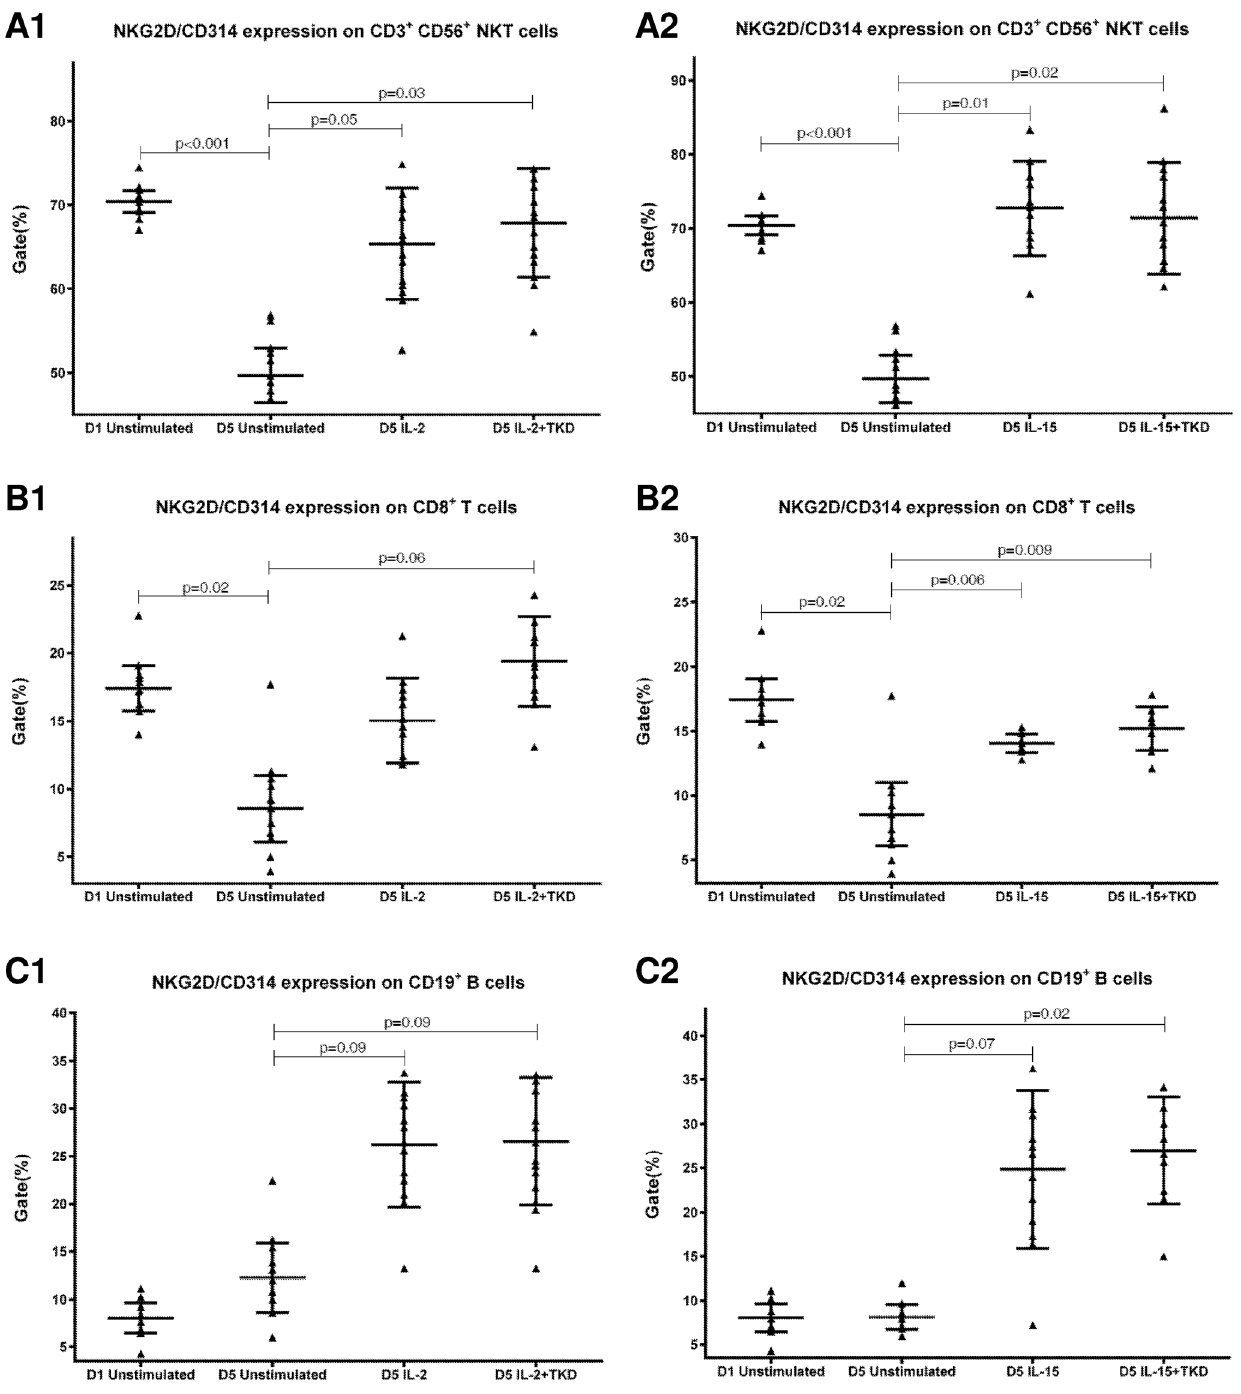
Fig 5. The effect of IL-2, IL-15, IL-2/TKD and IL-15/TKD on the expression of NKG2D receptor in peripheral blood mononuclear cells of healthy individuals — the proportion of CD3 + CD56 + NKT cells, CD8 + T cells and CD19 + B cells expressing an appropriate receptor. The expression of NKG2D receptor on CD3 + CD56 + NKT cells, CD8 + T cells and CD19 + B cells was examined within the fraction of unstimulated and stimulated mononuclear cells derived from 10 healthy individuals. Data are presented as means ± standard error. In total, the study cohort consisted of 52 Caucasian healthy individuals.